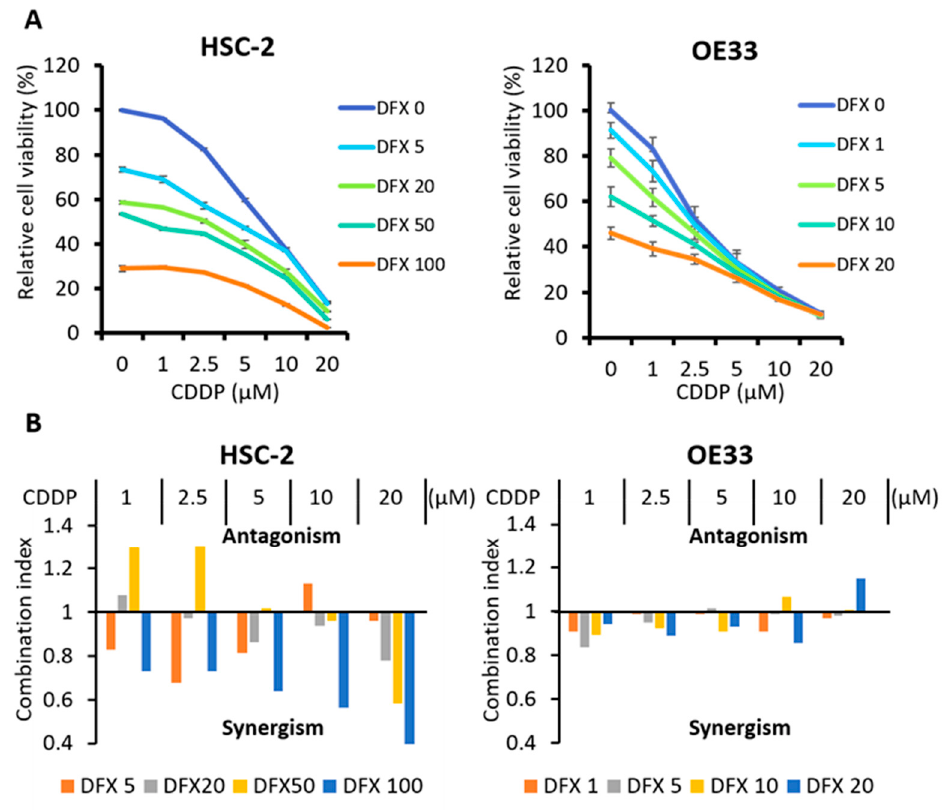
Figure 5. Cont Figure 5. Cont.